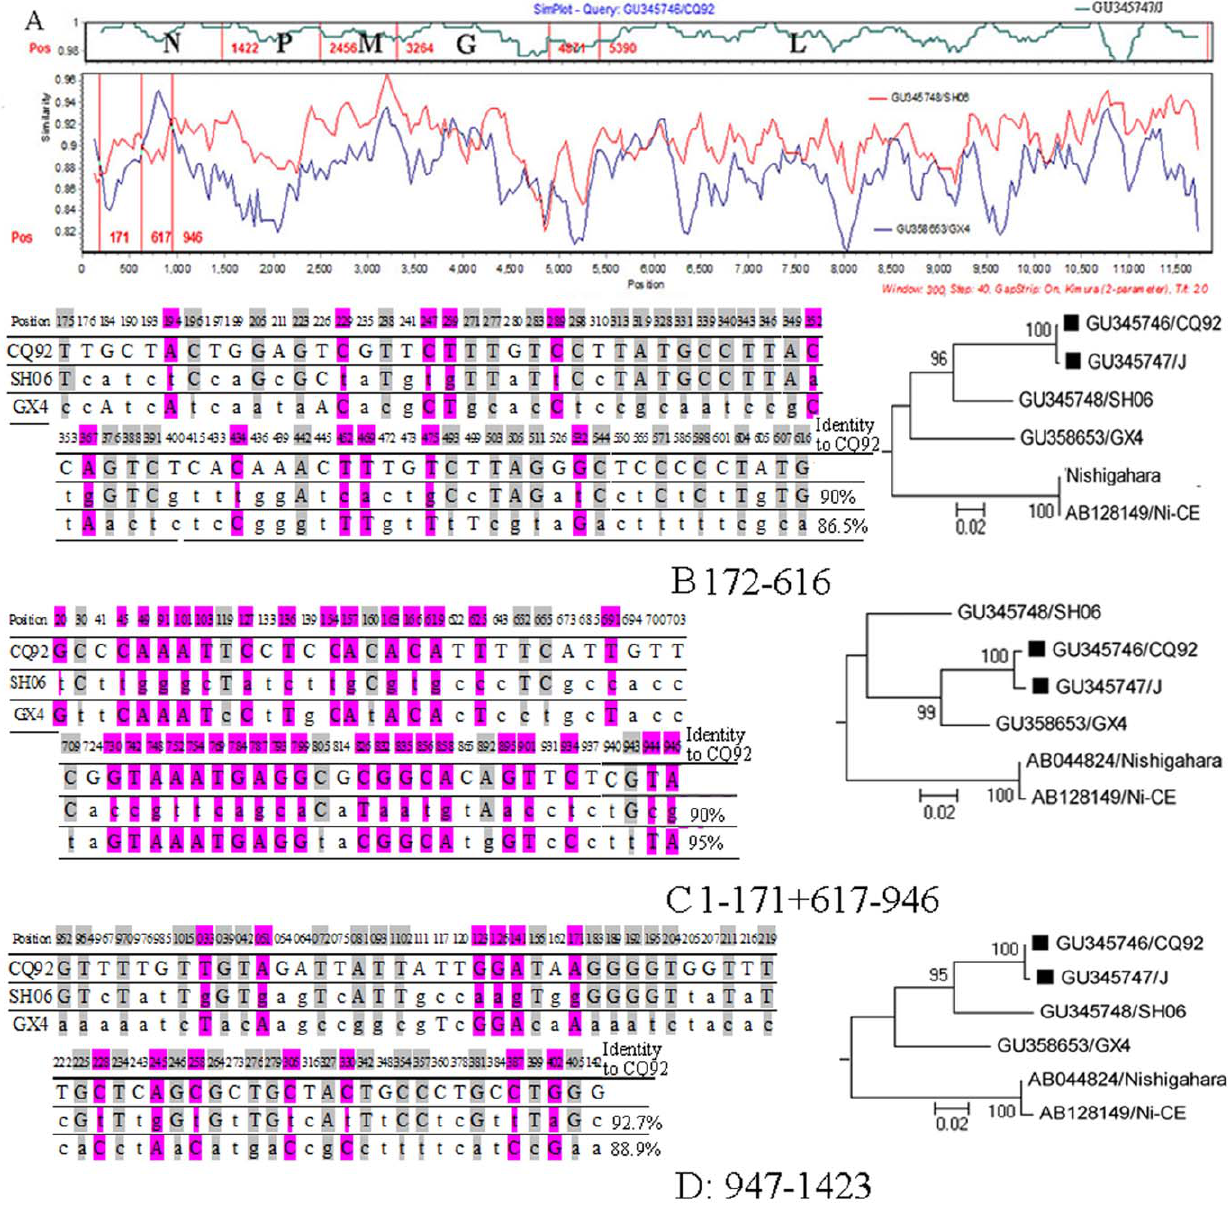
Figure 2. Sequence comparisons of J, CQ92, GX4 and SH06 rabies virus isolates. (A) A comparison of the genomic sequence of RABV isolates J, CQ92, GX4 and SH06. Strain CQ92 was used as the query. The y-axis gives the percentage of identity within a sliding window of 300 bp centered on the position plotted, with a step size between plots of 20 bp. The left side of (B), (C) and (D) panels showed the variant sites of CQ92 and its parent lineage representatives GX4 and SH06 in different genomic regions. The identity between CQ92 and its parent lineages is also shown in the middle of each panel. The variant sites identical to GX4 and SH06 are shaded in pink and grey, respectively. The right side of each panel shows the analysis of homology between CQ92 and parental lineages to show the different origins of CQ92. The phylogenetic histories of each region were inferred using the neighbor-joining method with a Tamura 3-parameter model. The robustness of each tree was tested by bootstrapping with 1000 replicates. Bootstrap values are shown beside the branches. (B) Positions 172–616. (C) Positions 1–171 and 617–941. (D) Positions 942–1423.